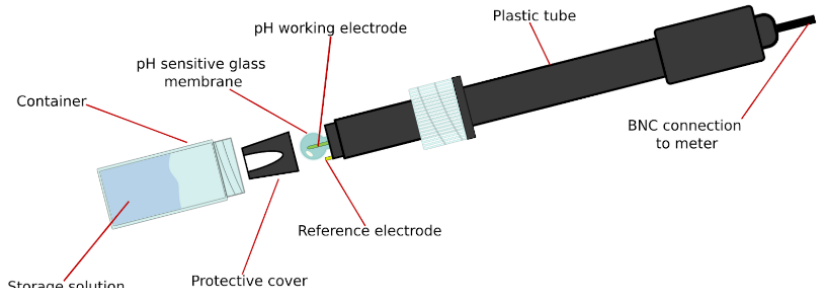
Figure 2. The implemented sensor consists of: a. Working electrode in contact with sample under study; b. Reference electrode interacting with solution of unknown pH; c. Protective cover; d. Storage solution; and e. Standard BNC connector for interoperability.